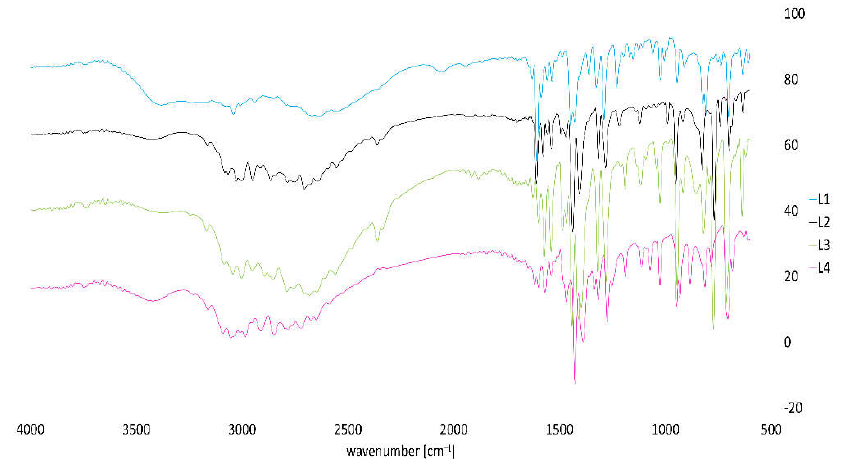
Figure 1. FTIR spectrum of free organic ligands.